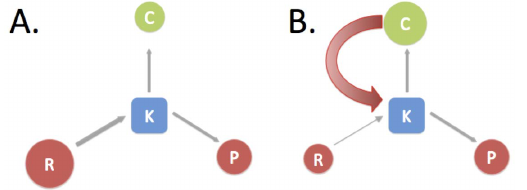
Figure 3. Schematic model of technology evolution. Quantities in circles ( C , P , R ) are observable inputs and outputs of innovation processes, while knowledge K is not observable. (A.) At early stages of a technology, markets C are typically very small and public R&D investments R are essential for generating new knowledge K and resulting patents P and product improvements. This has been the case for solar, wind and otherenergy technologies in the last few decades. (B.) As markets materialize, investments in innovation are increasingly driven by market growth (curved arrow), until this mechanism takes over. Market growth may be driven by public policy. At some point the technology may enter a cycle of rapid innovation (it takes off) and public R&D investment is no longer a dominant driver. Public R&D investments in innovation and those driven by market expansion have effects that are multiplicative, with each providing a base multiplier for the other. Any public R&D investment is highly leveraged by market driven investments as technologies develop towards stage B, as is presently occurring with several energy technologies such as solar and wind.